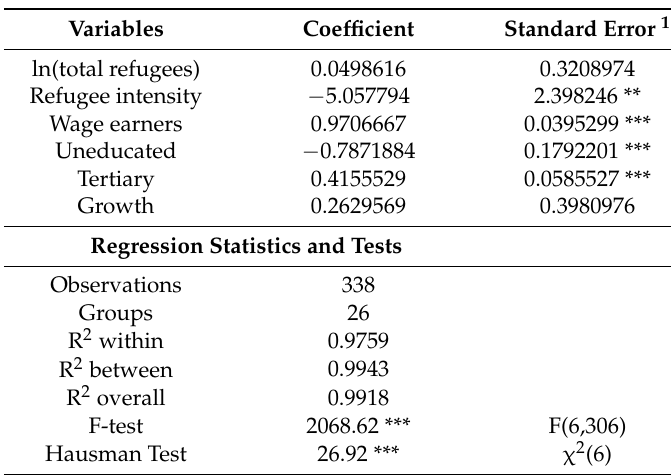
Table 4. Regression results: The determinants of formal